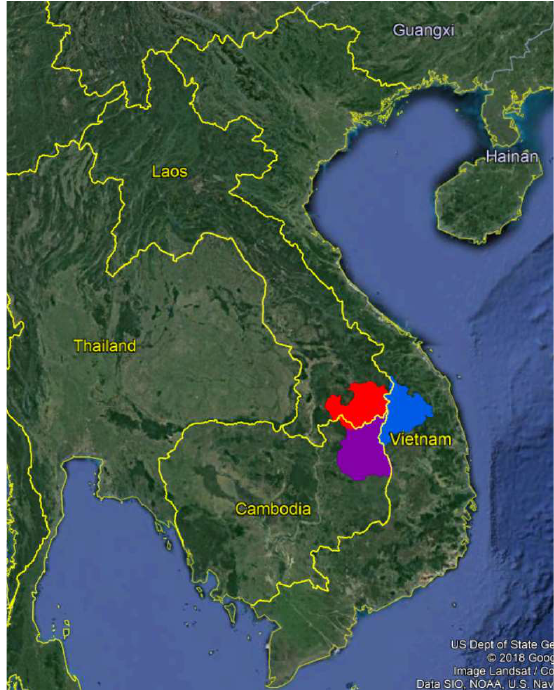
Figure 1. Study area with three provinces of Cambodia, Laos and Vietnam. Ratanakiri is coloured in violet, Attapeu in red and Kon Tum in